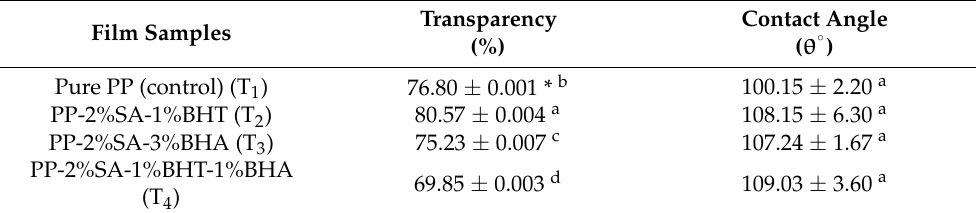
Table 3. The results of contact angle and the transparency of polypropylene (PP)-based active films.